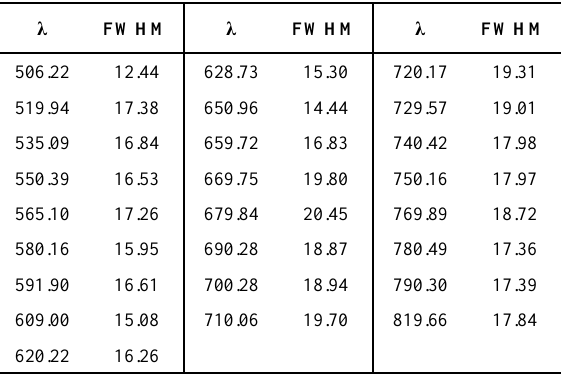
Table 2. Spectral setting of the FPI camera used to acquire the images use in this